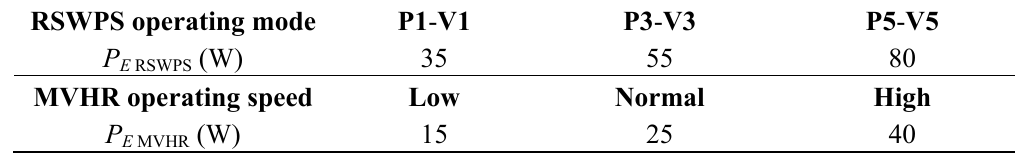
Table 3. Electrical power used by the RSWPS and the